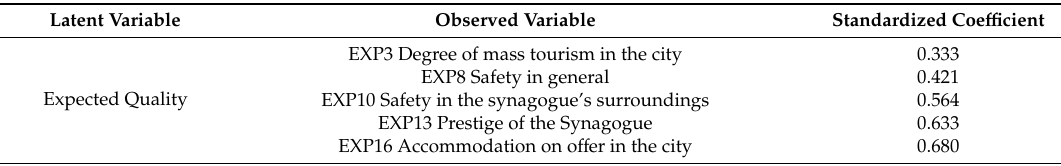
Table 2. Standardized structural coe ffi cients of the observed variables regarding the latent